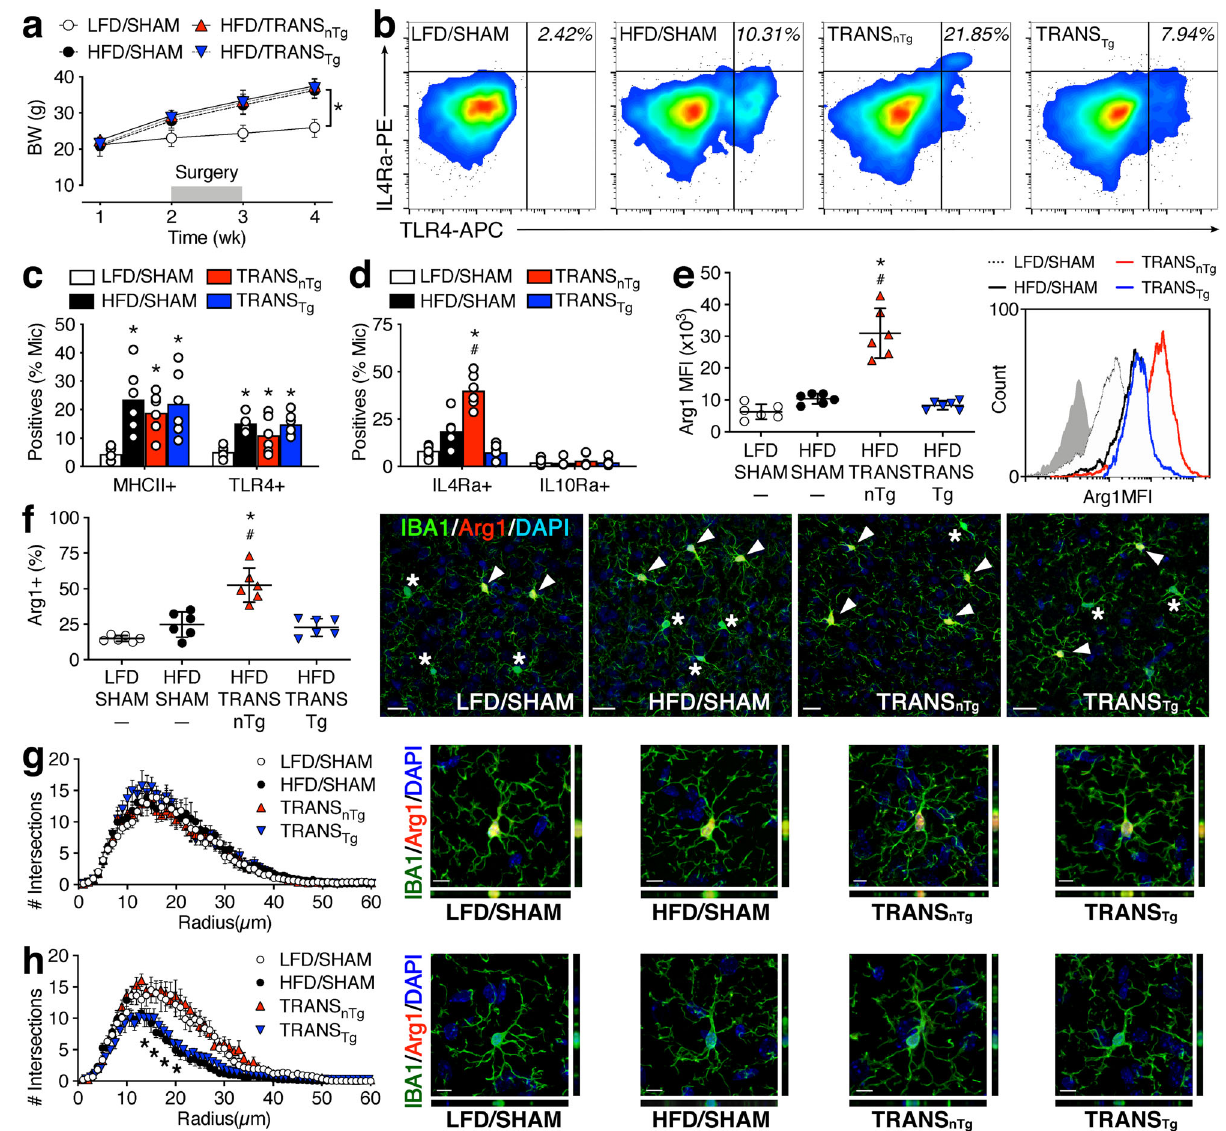
Fig. 4 Beige adipocytes alternatively activate resident microglia in early obesity. a Weight gain in Wt mice consuming a low-fat or high-fat diet (LFD, HFD) for 1 month, with a sham operation (SHAM) or transplantation of subcutaneous fat from a nontransgenic (TRANS nTg ) or Adiponectin cre /PRDM16 fl / fl transgenic donor (TRANS Tg ) during week 2. Symbols show group mean ± sem ( n = 12 mice/condition). b Co-induction of classical (TLR4) and alternative activation-associated markers (IL4Ra) in CD11b + /CD45 LO /Ly6C LO /CD169 − /TMEM119 + microglia from mice in the indicated conditions. Numbers in the upper-right quadrant represent TLR4 + /IL4Ra + events (% microglia). c Quanti fi cation of microglial MHCII and TLR4 revealed comparable pro- in fl ammatory polarization across all surgical conditions with dietary obesity. Symbols represent individual mice and bar height shows mean ± sem ( n = 6 mice/condition; applies to c , d ). d Beige adipose-dependent increases in microglial IL4Ra after SAT transplantation in HFD mice. e Left graph shows fl ow cytometric quanti fi cation of intracellular Arginase-1 (Arg1) mean fl uorescence intensities (MFI) in gated microglia. Symbols represent individual mice and lines show mean ± sem ( n = 6 mice/condition). Histogram (right) shows Arg1 MFI in gated microglia from representative samples in each condition (isotype shown in gray). f Quanti fi cation of Arg1 immunoreactivity in IBA1 + microglia on hippocampal sections. Symbols represent individual mice and lines show mean ± sem ( n = 6 mice/condition). Micrographs to the right of panels f – h depict representative labeling in the dentate molecular layer for the indicated groups. g Sholl analysis of Arg1 + microglia. Symbols represent mean ± sem from n = 6 mice/condition (5 Arg1 + cells per mouse). h Sholl analysis of Arg1 − microglia reveals selective reductions in anatomical complexity that are alleviated by SAT transplantation from an nTg donor. Symbols represent mean ± sem from n = 6 mice/condition (5 Arg1 − cells per mouse). Scale bar = 20 μ m for micrographs in f ; scale bar = 10 μ m for g , h . For all graphs, white circles represent LFD/SHAM; black circles, HFD/SHAM; red triangles, TRANS nTg ; inverted blue triangles, TRANS Tg . For a , repeated-measures ANOVA;